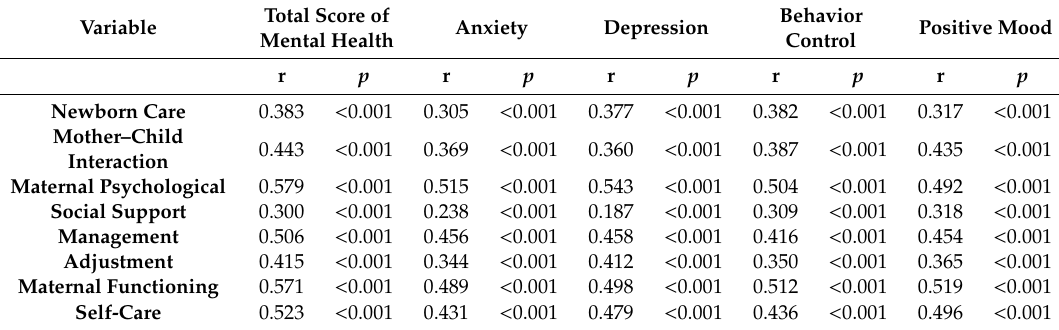
Table 3. The relationship between maternal functioning and mental health in women referred to health centers of Tabriz, Iran, 2019 ( n =